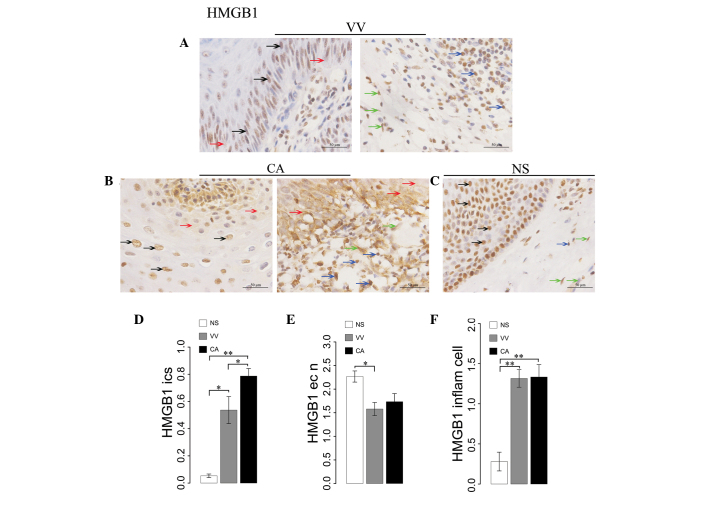
HMGB1 expression in NS and wart samples determined by immunohistochemistry EnVision (magnification, ×400). (A to C) HMGB1 positive expression is located in the nuclei, cytoplasm, cells and/or intercellular spaces following stimulation of cell necrosis or inflammation. The red arrows represent HMGB1 expression in the epithelial intercellular spaces, the black arrows represent HMGB1 expression in the epithelial cell nuclei, the blue arrows represent HMGB1 expression in inflammatory cells, and the green arrows represent HMGB1 expression in the vascular endothelial cells. (D) HMGB1 expression in the epithelial intercellular spaces. (E) HMGB1 expression in the epithelial cell nuclei. (F) HMGB1 expression in the inflammatory cells. The error bars represent the standard error of the mean. *P<0.05 and **P<0.01. HMGB1, high mobility group protein box 1; CA, condyloma acuminatum; VV, verruca vulgaris; NS, normal skin.